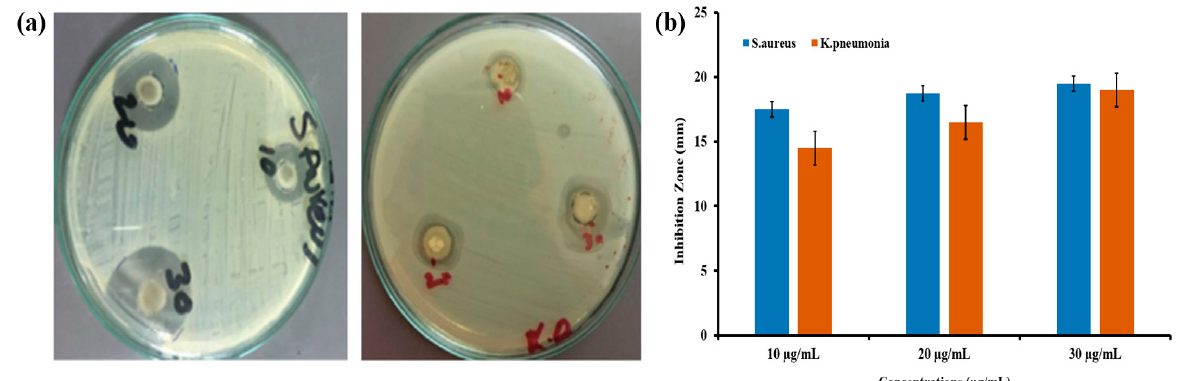
Figure 6. ( a ) Clear inhibition zone formed by synthesized CeO 2 NPs using the Abelmoschus Esculentus extract against S. aureus and K. pneumonia . ( b ) Histogram representation for all measured inhibition zones at different concentrations of CeO 2 NPs.